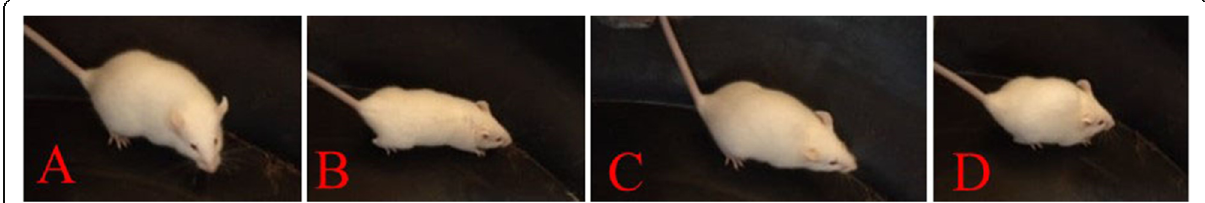
Fig. 6 ( a ) Control group, ( b ) 0.3 mg/kg vincristine sulfate, ( c ) 200 mg/kg, ( d ) 400 mg/kg. Pictorial presentation of EAC cell bearing Swiss albino mice after treating with Chenopodium album leaf extract at concentration 200 (mg/kg), 400 (mg/kg), and standard drug 0.3 (mg/kg) vincristine sulfate (VS) and with the increasing of the dose the tumor bearing mice size and weight was reduced that indicate dose dependence